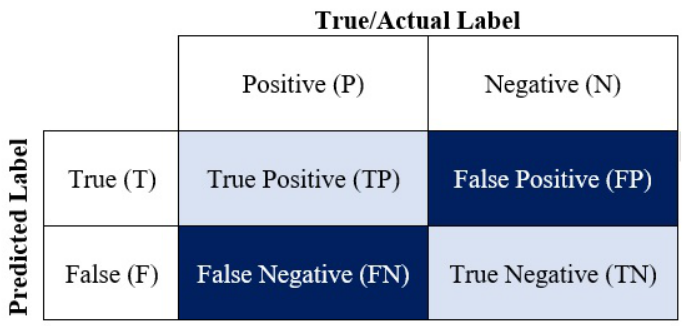
Figure 10. Structure of a confusion matrix for a binary